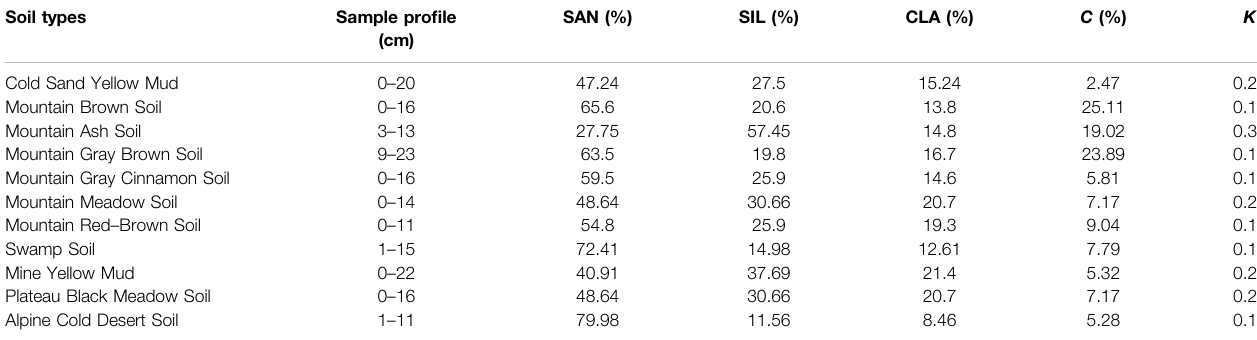
TABLE 1 | Main soil physical and chemical parameters and K value in the upper reaches of the Minjiang river. Soil types